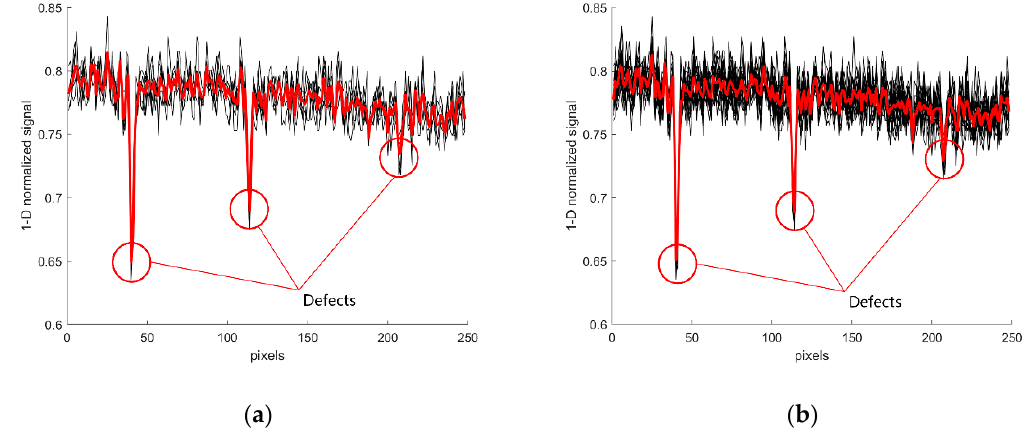
Figure 6. Image superposition with different number of sheets ( a ) superposition of six vehicle images ( b ) superposition of 20 vehicle images.